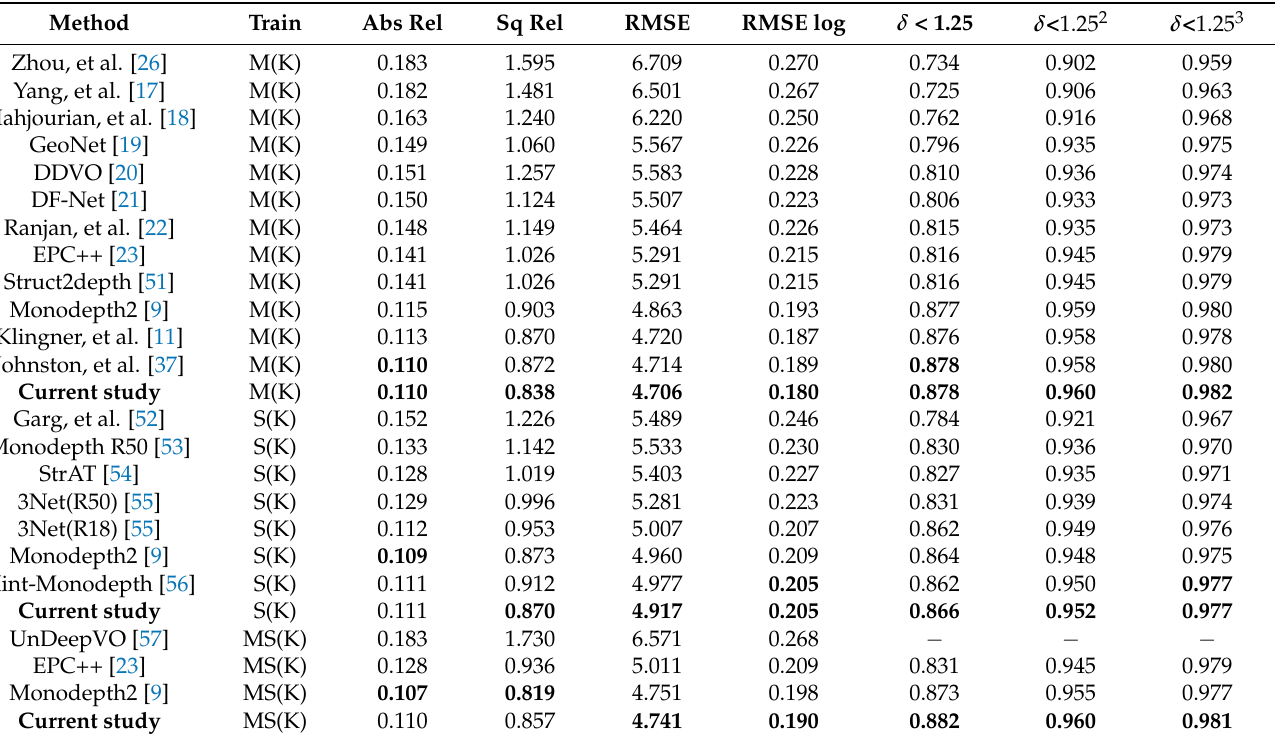
Table 1. Validated with Eigen split on the KITTI 2015 dataset and then compared with existing models. M(K): a self-supervised monocular model trained on KITTI, S(K): a self-supervised stereo model trained on KITTI, MS(K): a self-supervised monocular plus stereo model trained on KITTI, K: KITTI. The best results are identified in